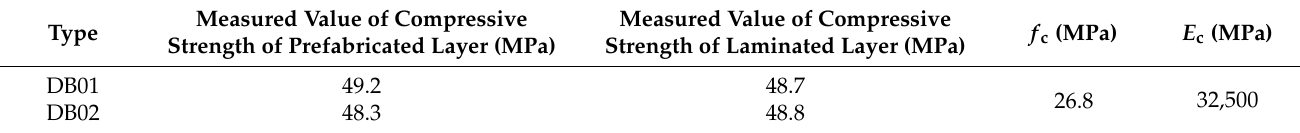
Table 3. Mechanical properties of concrete